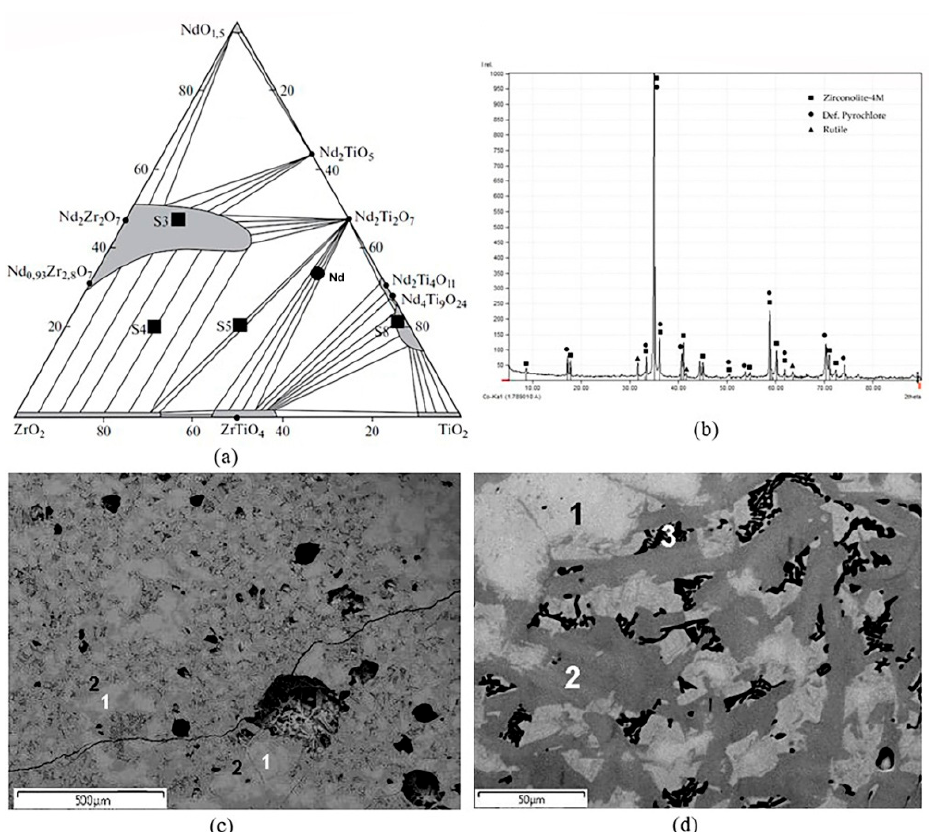
Figure 9. ( a ) Position of the “Nd” sample, ( b ) its X-ray diffraction pattern, and ( c,d ) SEM/EDS images: 1—pyrochlore, 2—zirconolite, 3—rutile (black) with fine pyrochlore inclusions. The scale bars on the SEM images are ( c ) 500 and ( d ) 50 µm. Markers on the XRD pattern show the peak positions only. The high-resolution diffraction pattern is given in Appendix B.